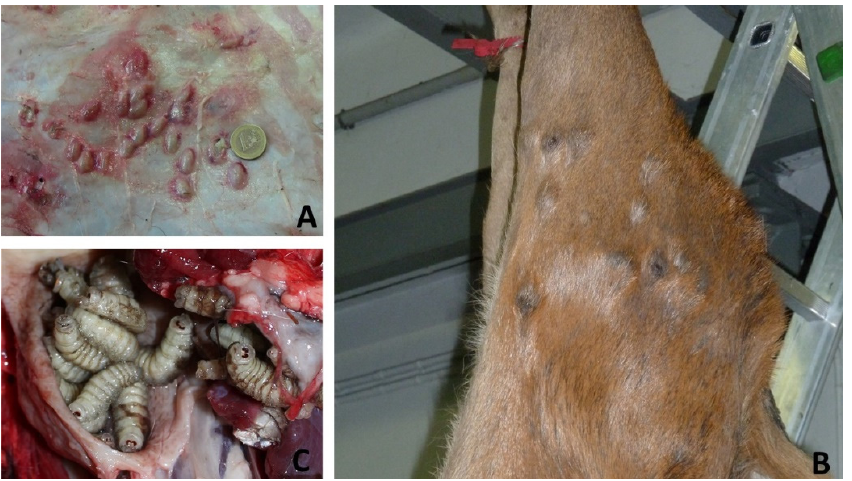
Figure 2. Macroscopic view on Hypoderma diana ( A ), Onchocerca jakutensis nodules ( B ), Pharyngomya picta ( C ) on deer from different areas of Piedmont (see Figure 3).